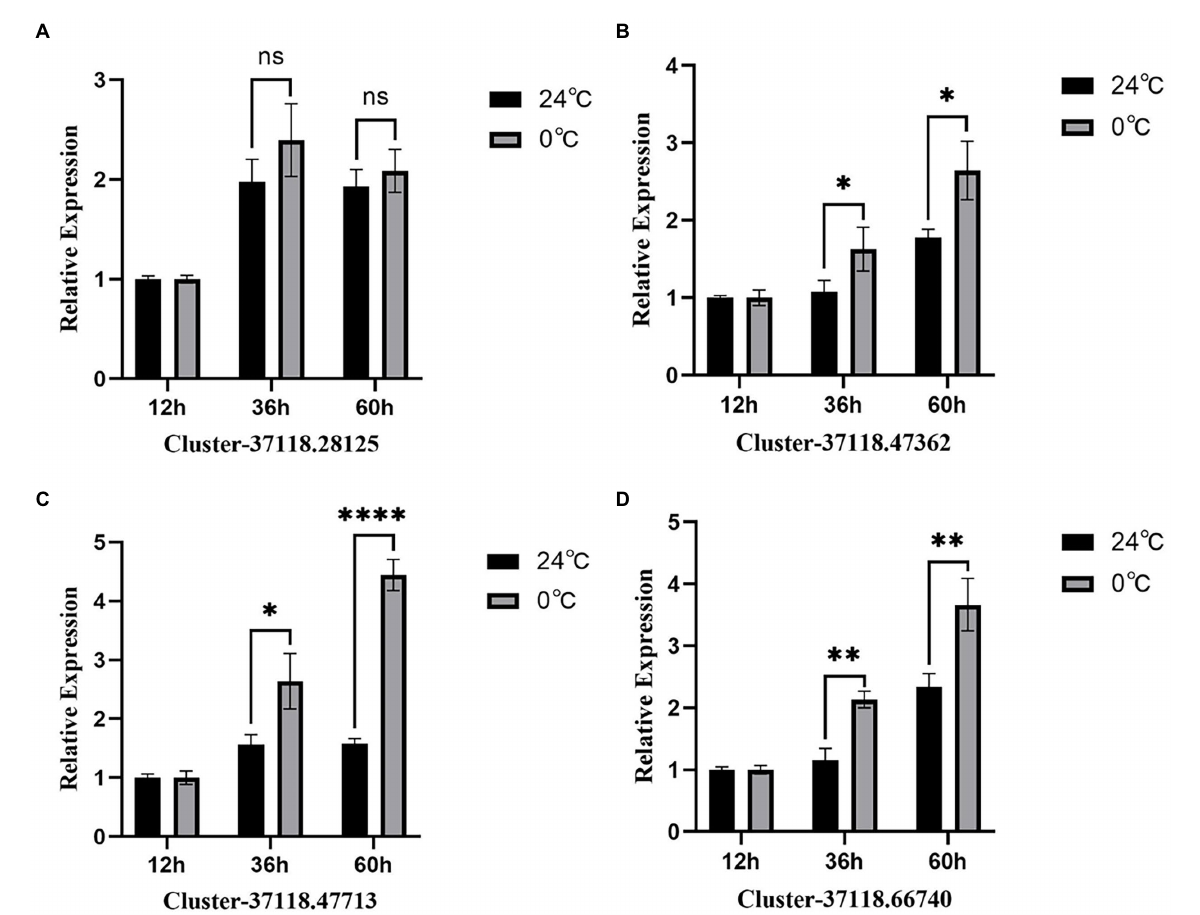
FIGURE 7 RT-PCR analysis of the four hub genes from the brown module. (A–D) are the expression results of four hub genes, respectively. * represents p <0.05, ** represents p <0.01, *** represents p<0.001, **** represents p